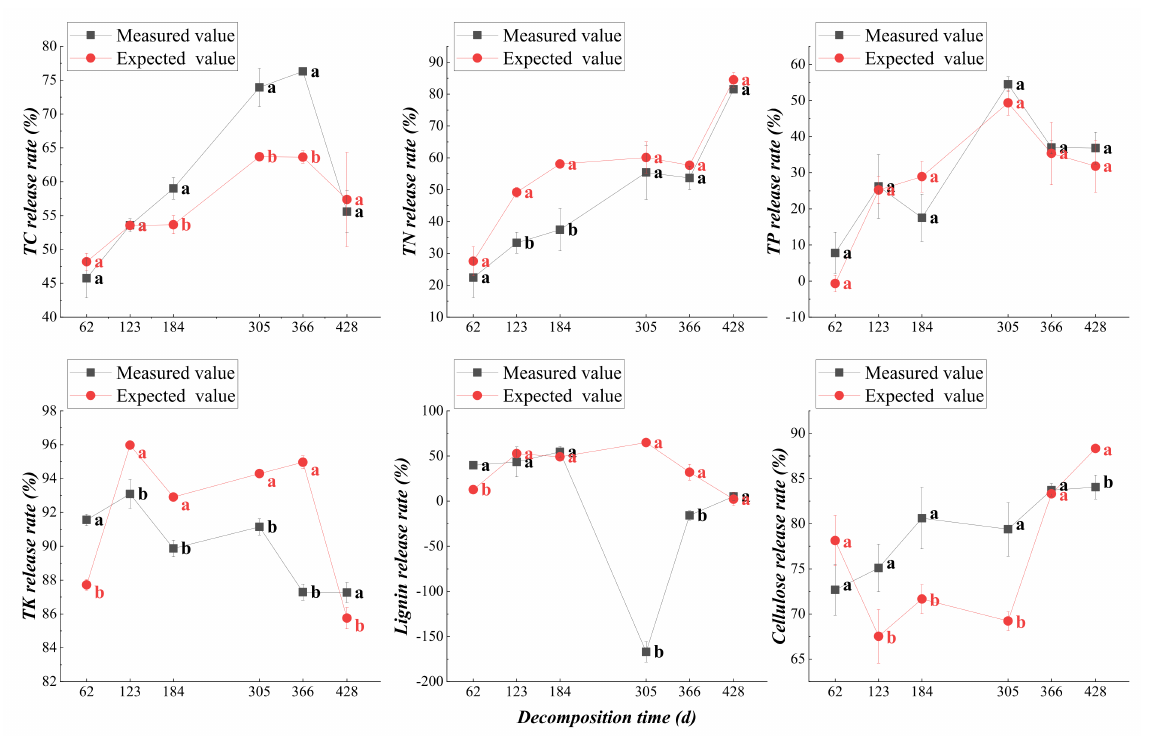
Figure 10. Measured and expected values of the nutrient release rates during CCG plant residue decomposition. Note: a, b—differences between expected value and measured value in the same decomposition period ( p < 0.05).